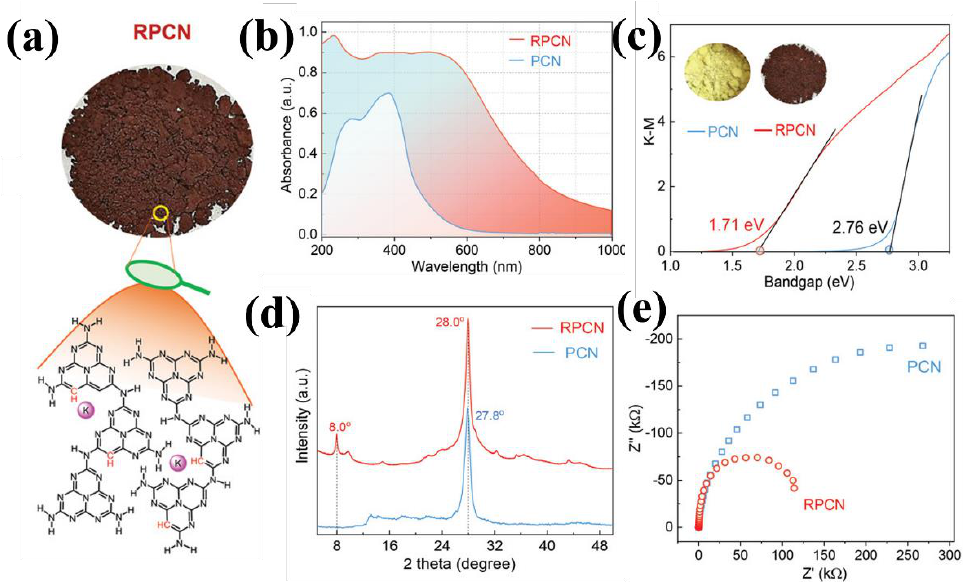
Figure 6. ( a ) Physical photo of red RPCN and a schematic diagram of the atomic structure. ( b ) UV-vis DRS spectra, ( c ) Kubelka-Munk plots, ( d ) XRD patterns and ( e ) electrochemical impedance spectra of PCN and RPCN [50].